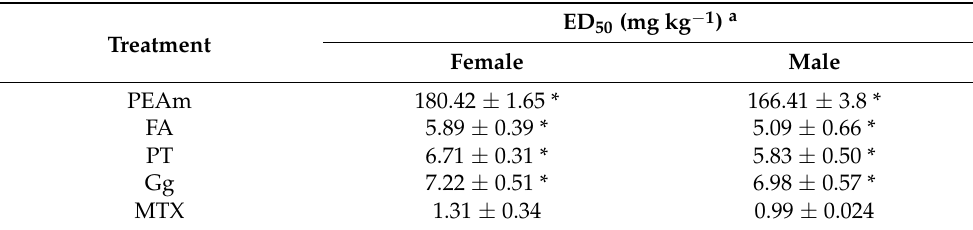
Figure 6. Weights (in g) of left axillary (LA), right axillary (RA), left inguinal (LI) and right inguinal (RI) lymph nodes of female ( A ) and male ( B ) mice, compared with healthy control (HC), control without treatment at 28 days (C1) and control without treatment at 65 days (C2) groups. Results obtained by ANOVA one-way analysis followed by Dunnett’s test for multiple comparison. Data are expressed as mean ± SEM, (n = 6); * p < 0.05 vs. HC, + p < 0.05 vs. C1. Table 5. Results of the antilymphoma activity after administration of petroleum ether extract, geranylgeraniol (Gg), phytol (PT), and farnesyl acetate (FA) obtained from the leaves of A. macroprophyllata on male and female mice inoculated with U-937 cells.